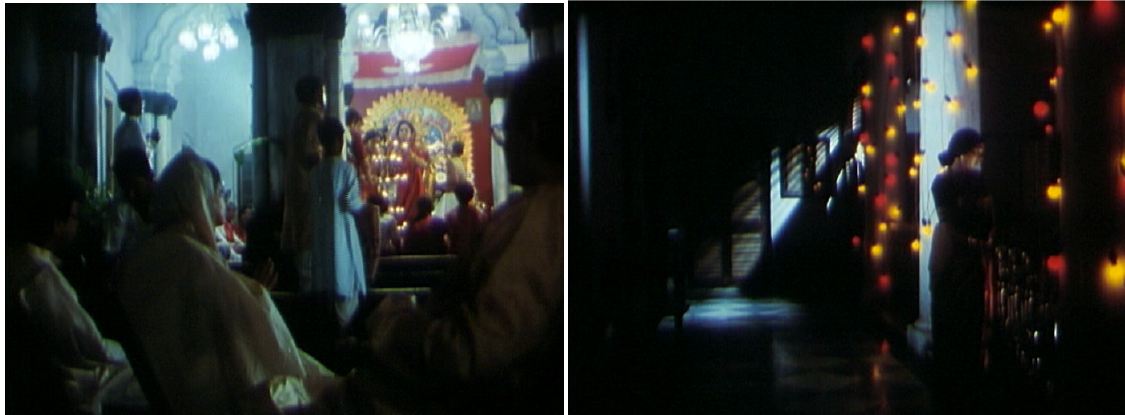
Figure 13. Bhagabati watching the puja (left), Keya watching the puja (right), screen grabs, Utsab